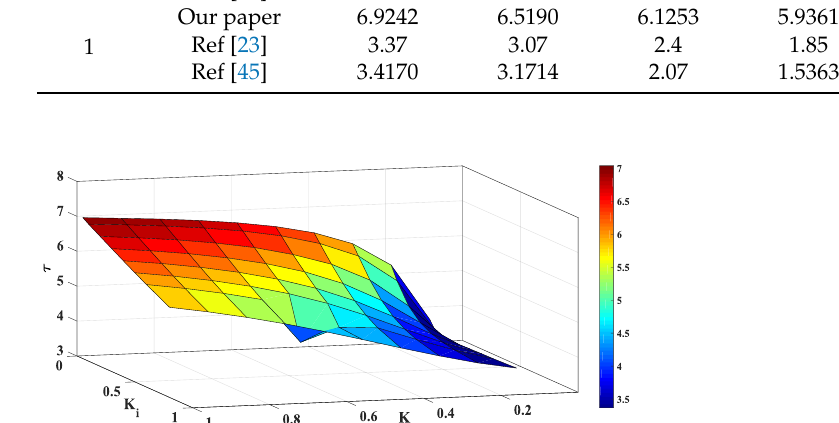
Figure 6. Maximum permitted delay for an EV aggregator with α 1 = 0.2 and τ M